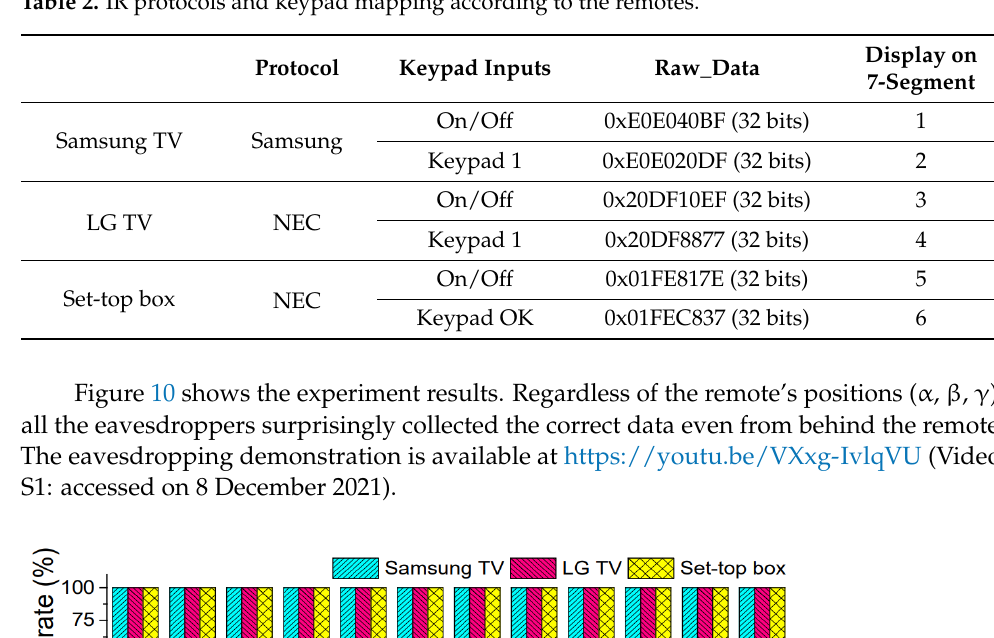
Figure 9. Eavesdropping experimental environment: eavesdropper’s position ( a (cid:13) ~ l (cid:13) ) and remote’s position ( α , β , and γ ). Table 2. IR protocols and keypad mapping according to the remotes.